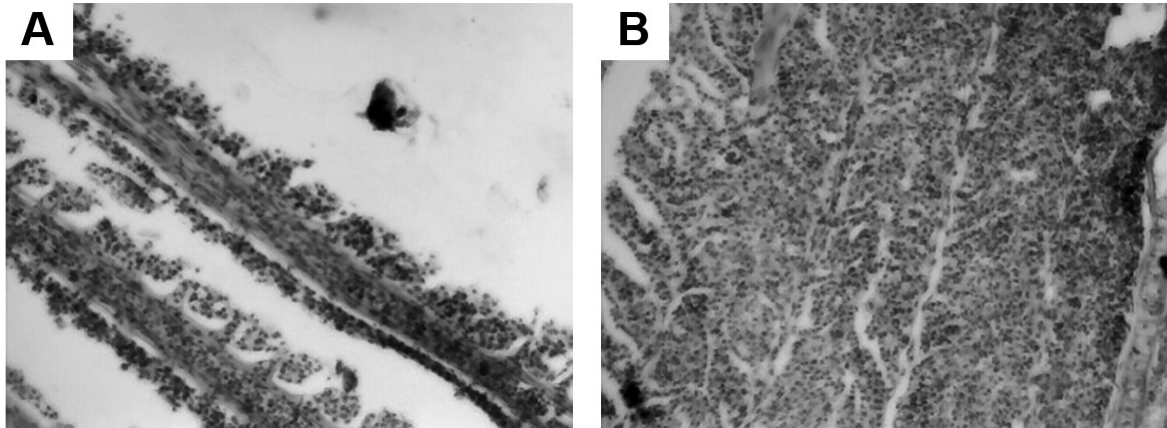
Figure 2 - a. Gill lamellae of Coridora exposed at concentration of 50 mg.L -1 formaldehyde showing hyperplasia. HE 200x. b. Gill lamellae of Coridora in concentration of 100 mg.L -1 formaldehyde showing epithelial hyperplasia with filling of interlamellar spaces. HE 200x.